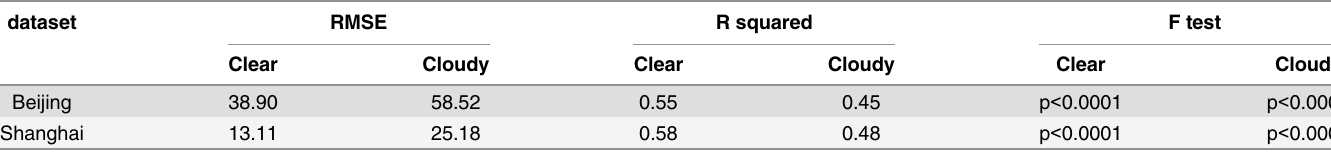
Table 2. Regression results for different weather conditions. dataset RMSE R squared F test